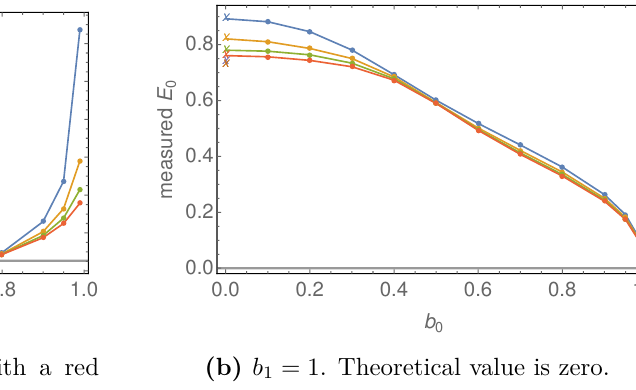
Figure 22. The mass-coupling relation as measured using H 0 = H ShG b 0 (two in the left panel and two in the right). The mass of the unperturbed theory at b 0 is plotted as a large unfilled circle while the masses derived at neighbouring values of b 1 are shown as dots of the same color.